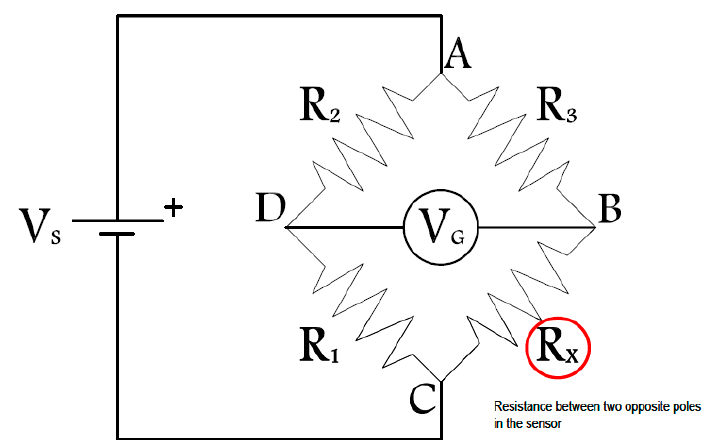
Figure 4. Wheatstone bridge.